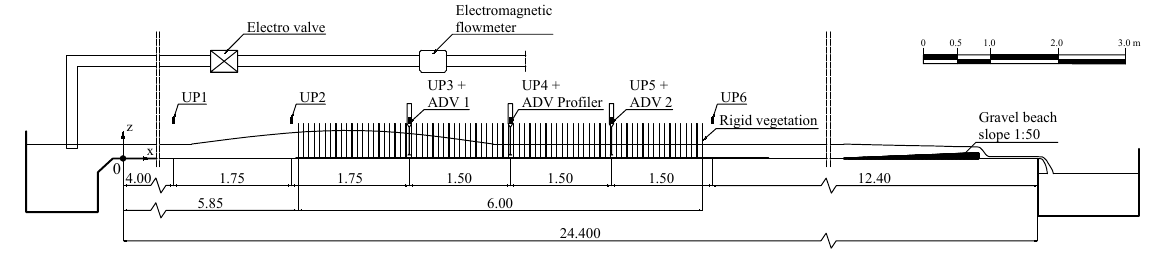
Figure 1. Side view of the experimental setup, with the positions of the Ultrasonic Probes (UPs) and the Acoustic Doppler Velocimeters